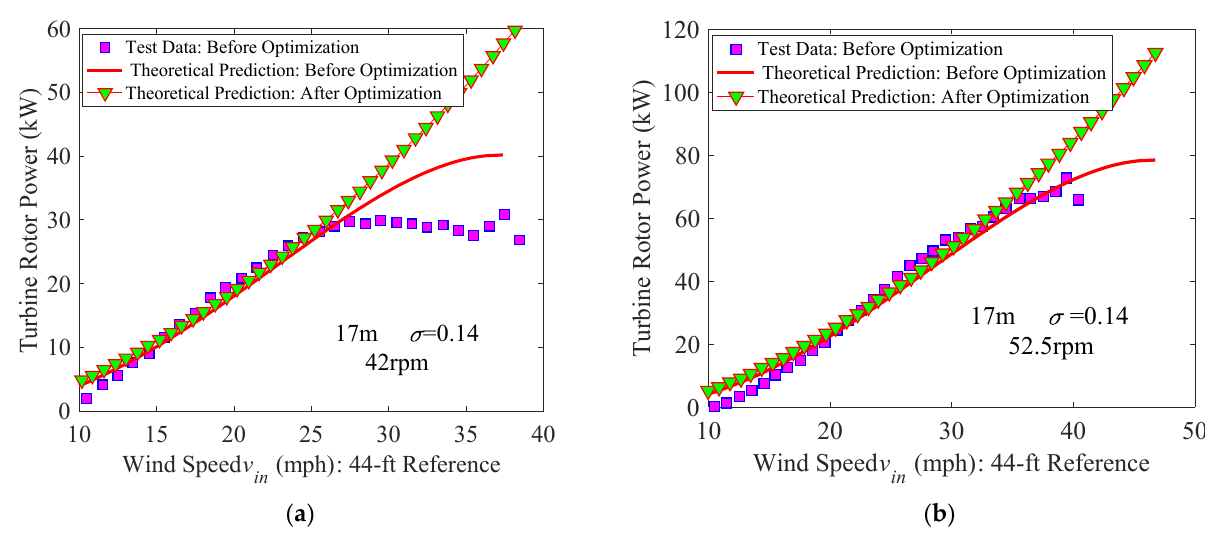
Figure 25. Idealized optimization for the Sandia VAWT [2]: ( a ) Ω = 42 rpm and ( b ) Ω = 52.5 rpm.